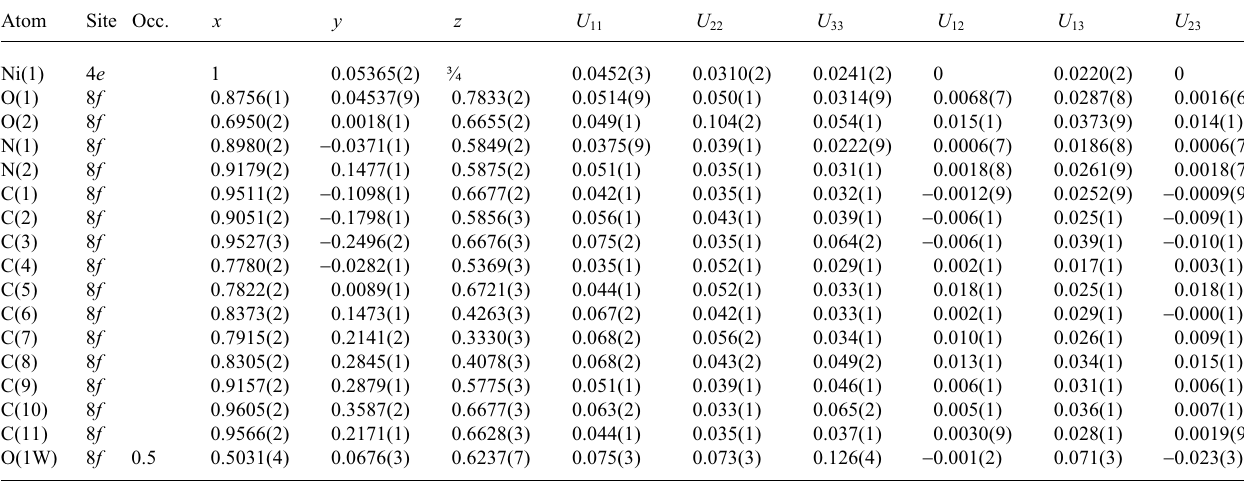
Table 3. Atomic coordinates and displacement parameters (in Å 2 )